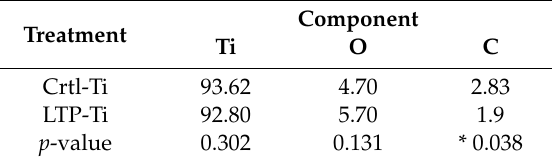
Table 1. Energy dispersive spectrometer values.